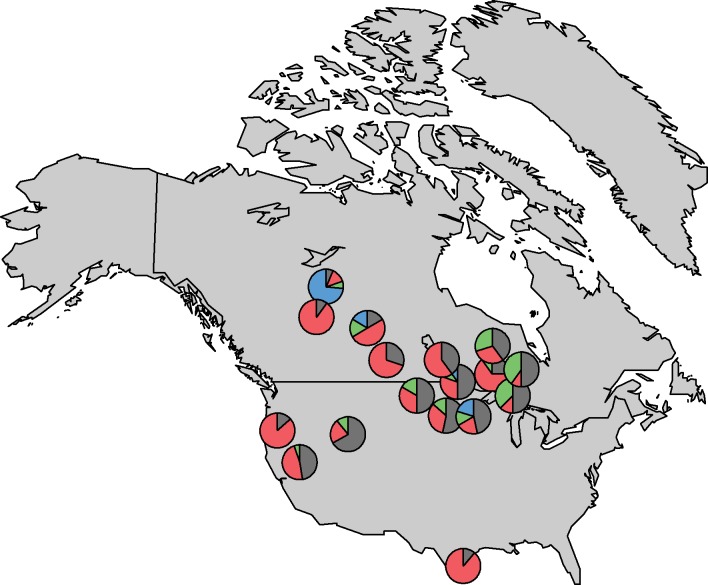
Cluster Membership Map.Proportion of feather samples from pelicans at 17 breeding colonies that fall into one of four clusters, based on k-means cluster analysis. The four colours (grey, red, blue, green) represent the proportion of samples assigned to each of the four different clusters defined by the clustering algorithm. Some colony locations have been slightly offset for better visibility.